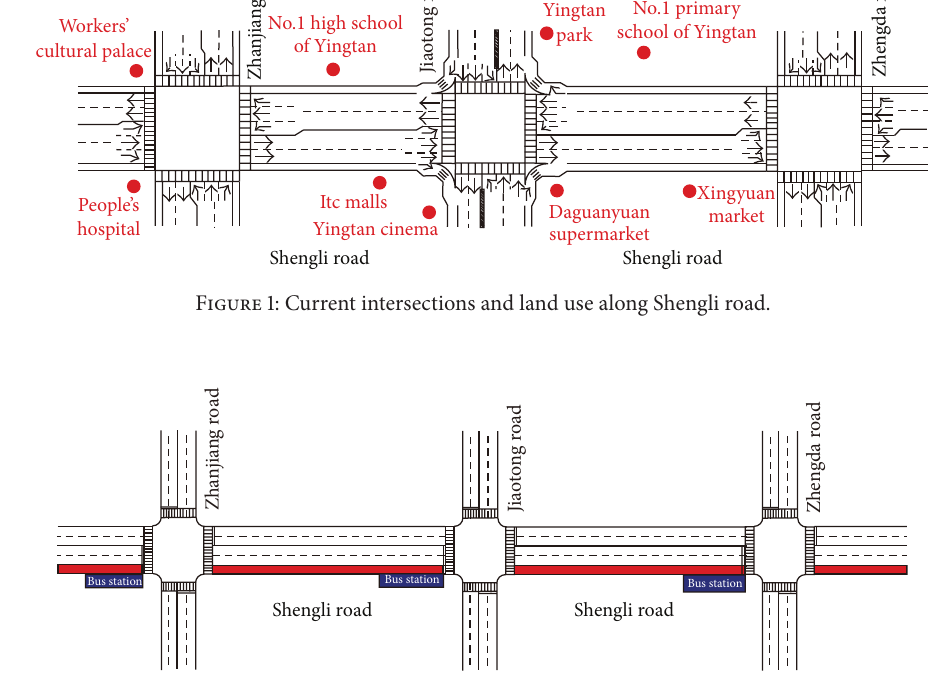
Figure 2: The exclusive lane and bus stops of BRT planned on Eastbound Shengli